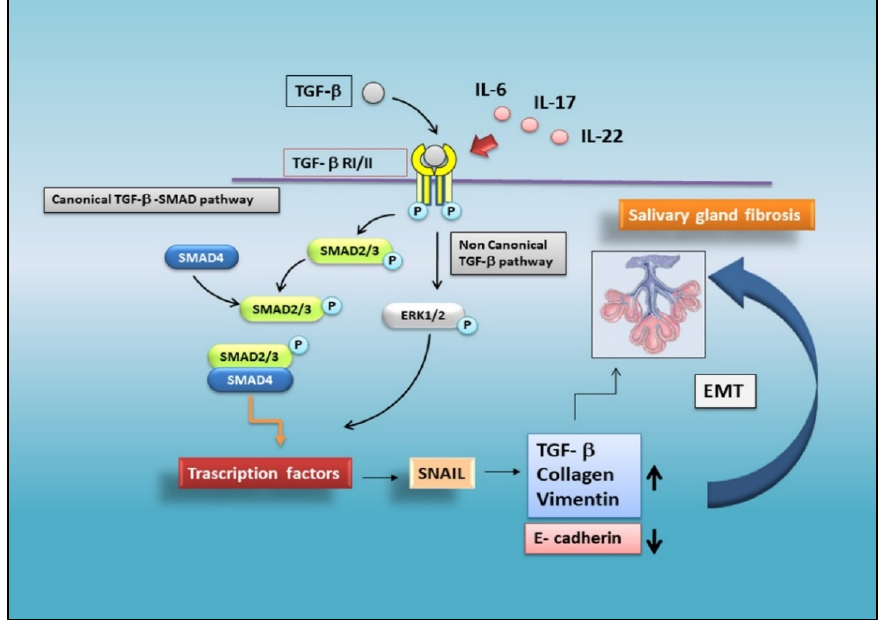
Figure 1. Schematic representation of TGF- β -mediated EMT signalling in SS. In a situation of chronic inflammation, TGF- β activates the canonical SMAD2/3 and the non-canonical ERK-mediated pathways, triggering the EMT process in salivary gland epithelial cells. The activation of transcription factors (such as SNAIL), promotes the prolonged induction of EMT, repressing epithelial marker genes and activating genes linked to the mesenchymal phenotype. Pro-inflammatory cytokines, such as IL-17, IL-22, and IL-6, induce EMT-dependent severe fibrosis in